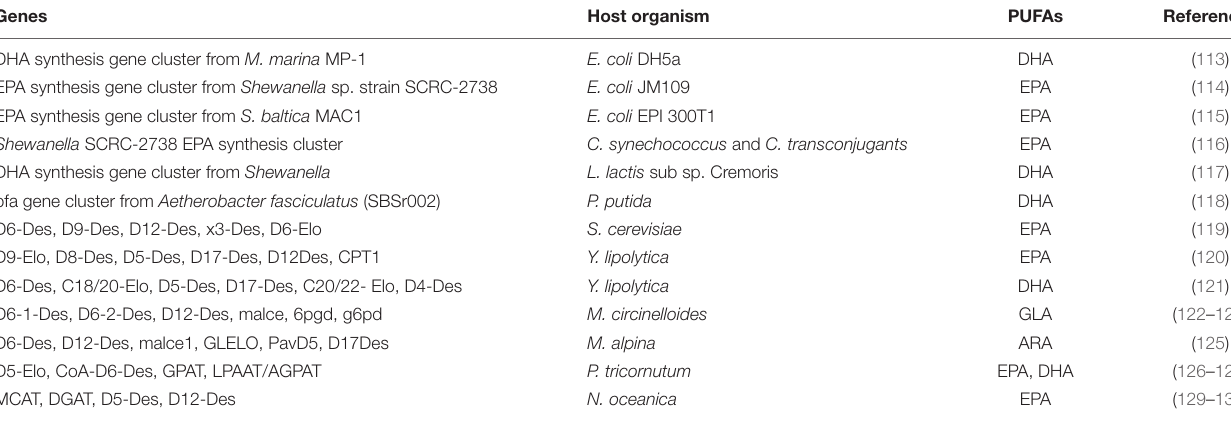
TABLE 3 | Summary of genetic engineering of different enzymes in microbes to boost the production of PUFAs.